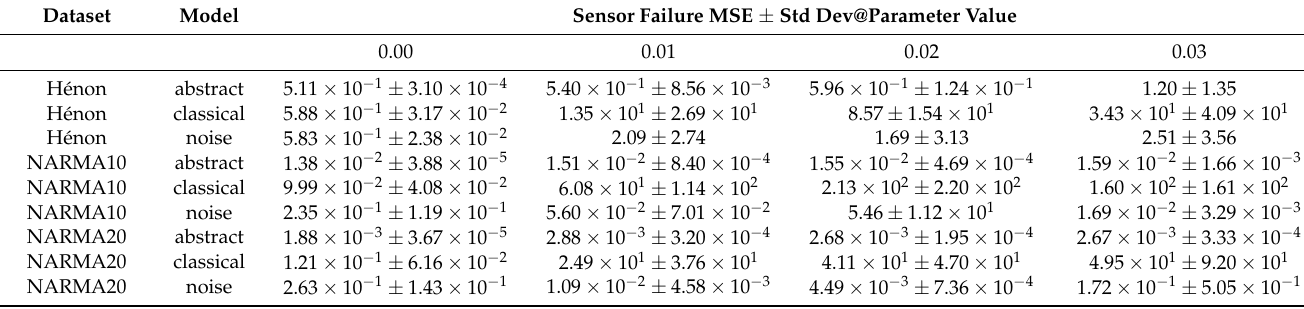
Table A1. Average MSE for the experiments simulating failing sensors over 10 experiment runs. The parameter gives the fraction of sensors that were forced to